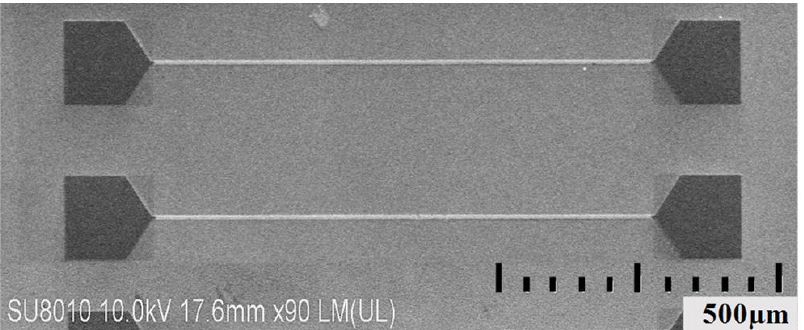
Figure 1. Structure diagram of GO-Si based metal-semiconductor junction resistor CVD-GO gas sensor.